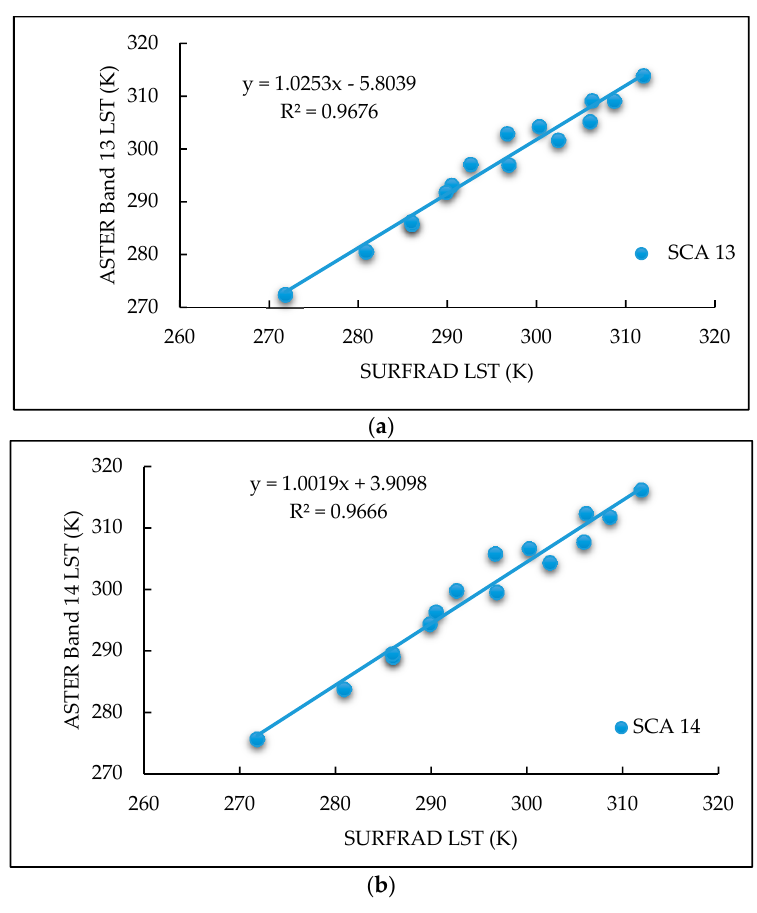
Figure 3. Comparison of scatter plots of LST inverted from ASTER data and LST derived from SURFRAD station at four SURFRAD stations: ( a ) scatter plot for LST values derived from ASTER band 13 using the SCA and the LSTs derived from SURFRAD measurements; and ( b ) scatter plot for LST values derived from ASTER band 14 using the SCA and the LSTs derived from SURFRAD measurements.